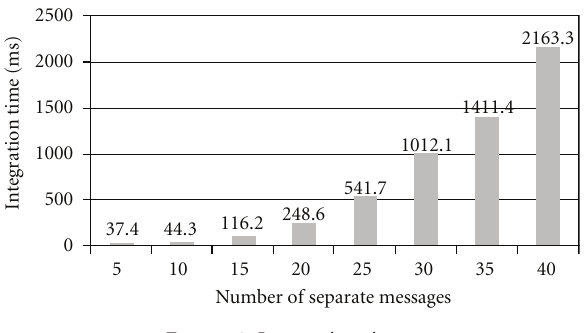
Figure 8: Integration